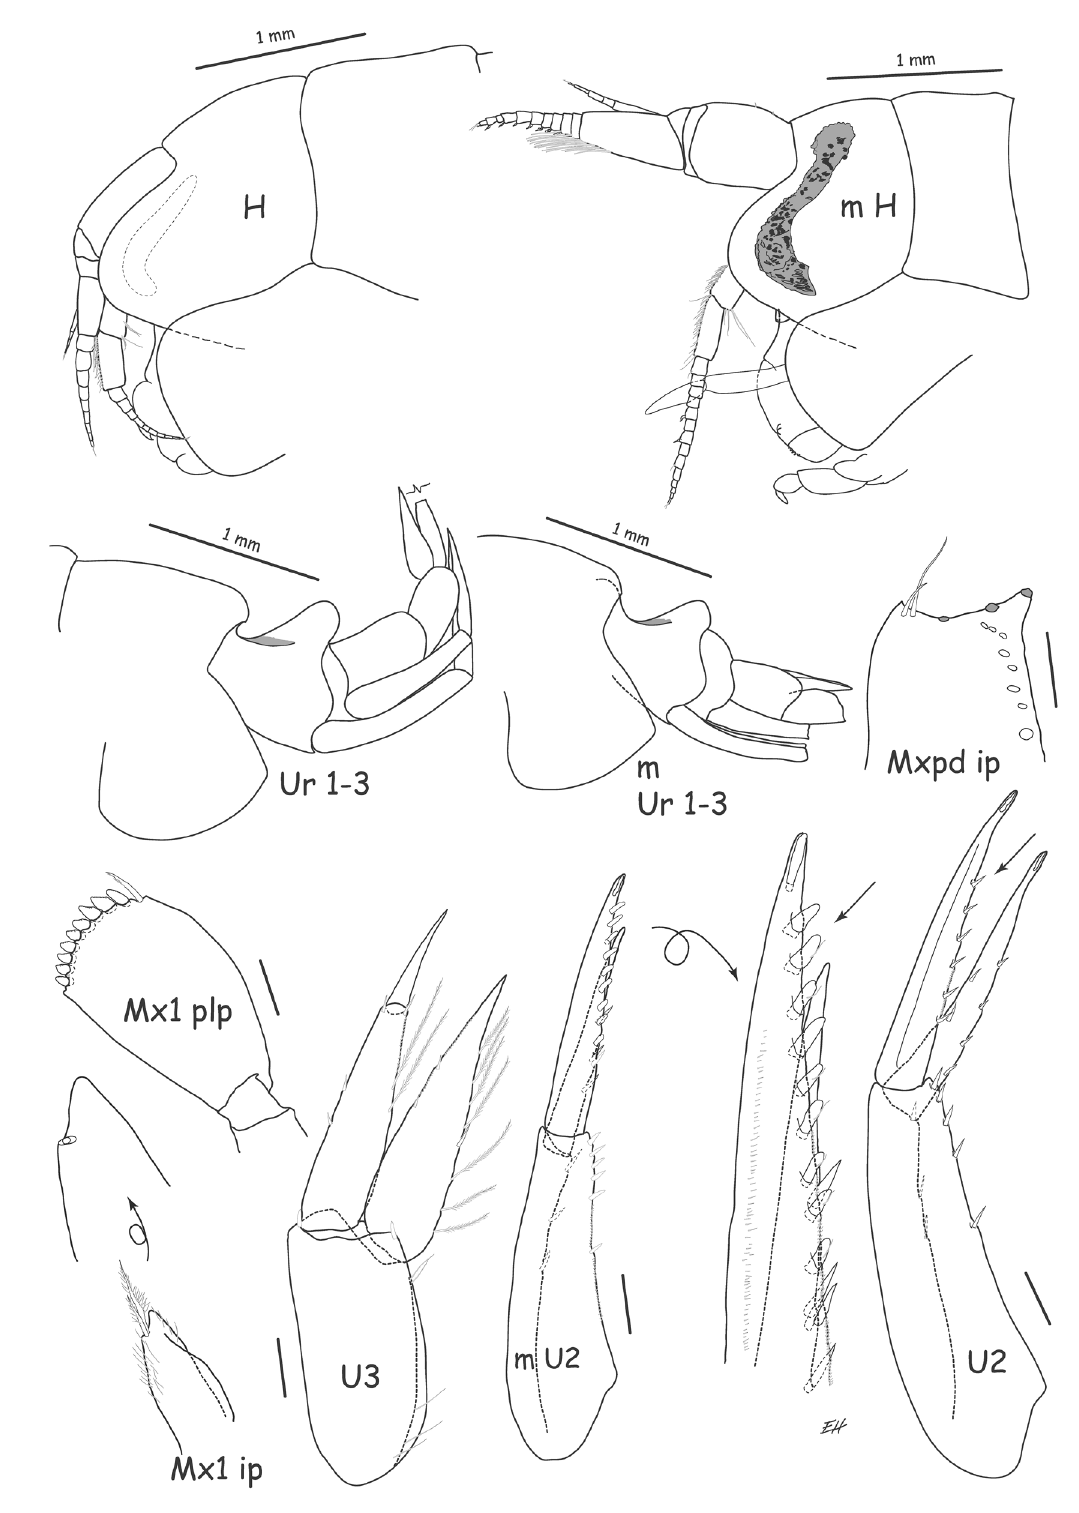
Fig. 2. Abyssorchomene abyssorum (Stebbing, 1888), ♀, 9.5 mm (ZMH K-61206); ♂, 7.0 mm (ZMH K-61207), DIVA-3 M79/1 station 531, Southwest Atlantic, Argentine Basin, depth 4586 m., 15 July 2009. Female eye position/size shown is approximate. Outer ramus is oriented on the left side of the uropods. Figures with sex not indicated are of female. Scale bars = 0.1 mm unless indicated